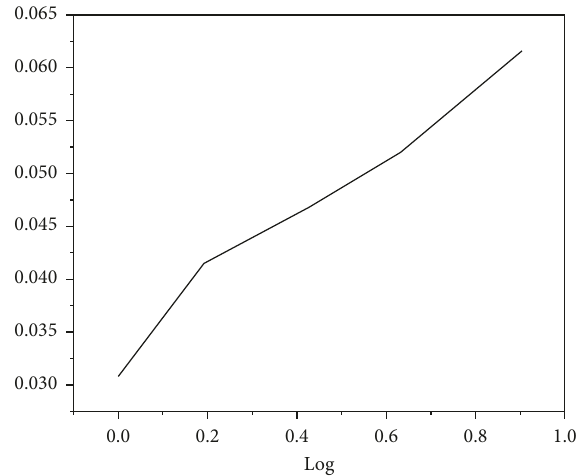
Figure 3: Molybdenum/boron nitrogen codoped two-dimensional nanocarbon composite structure and commercial Pt/C